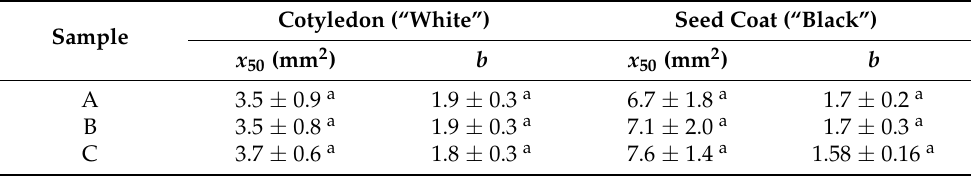
Rammler parameters considering “all” (Table 1), “black”, and “white” (Table 2) particles, from all 17 participants. Table 2. Estimated Rosin-Rammler parameters (Equation (2)) of the particles of black bean cotyledon (“white”) and seed coat (“black”) from samples A (PEF and thermally processed without CaCl 2 addition), B (PEF and thermally processed with CaCl 2 addition), and C (No PEF, thermally processed with CaCl 2 ) after in vivo human mastication (average of 17 participants).